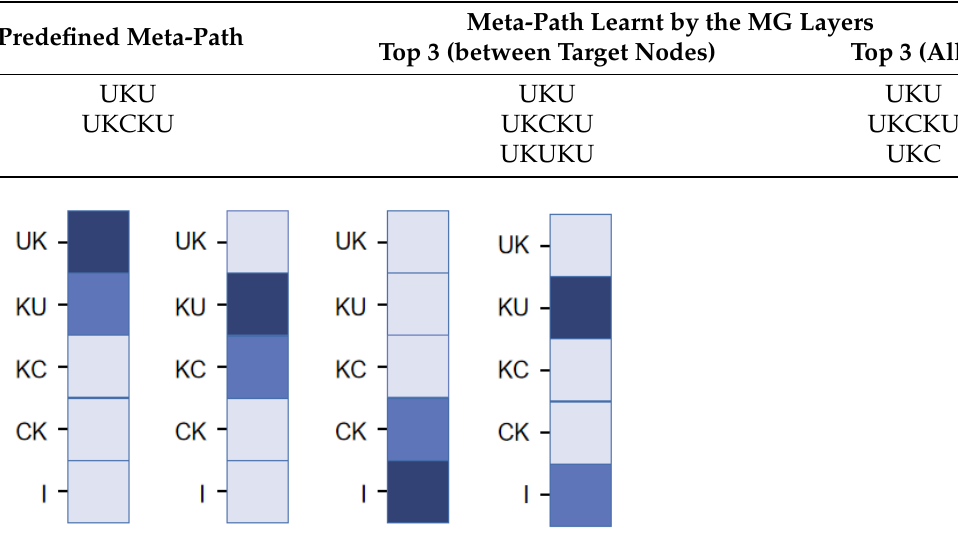
Table 4. Predefined meta-paths and generated meta-paths by the MG layers.